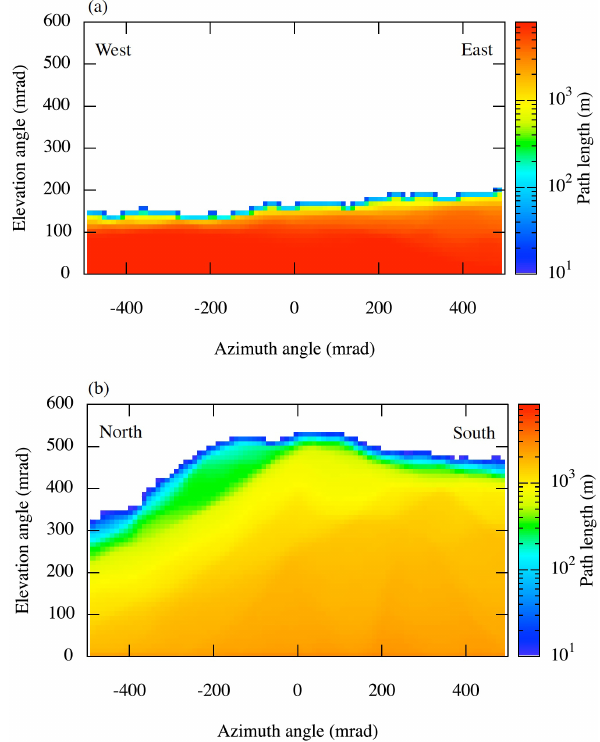
Figure 8. Path length distribution of volcanoes viewed from dif- ferent distances. The solid angle when viewing a larger volcano (Shinmoe-dake) (a) is smaller than that when viewing a smaller vol- cano (Satsuma–Iwo Jima) (b) if the distance to the target is